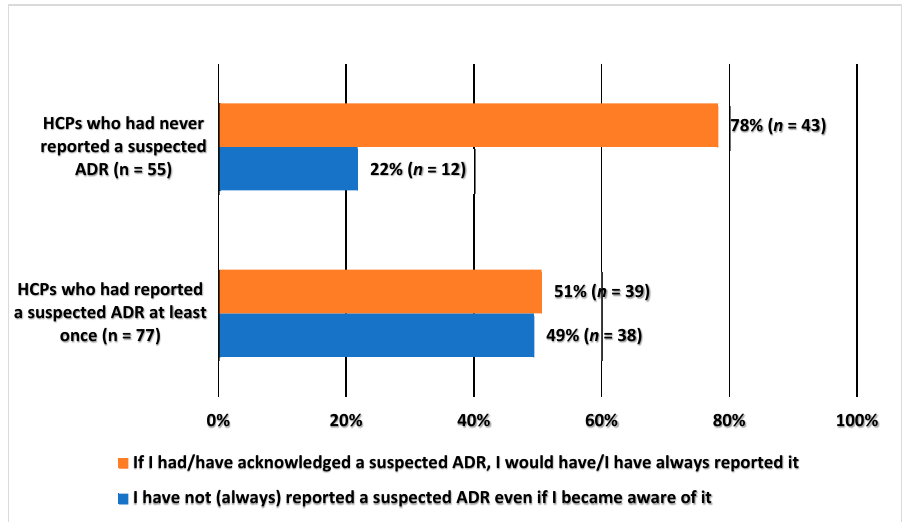
Figure 3. Healthcare professionals’ (HCPs) answer to the question of whether they had always reported suspected adverse drug reactions (ADRs) that came into their knowledge, percentage (%) of HCPs. Comparing the group of HCPs who had never reported ADRs with the group of HCPs who had reported at least one ADR.